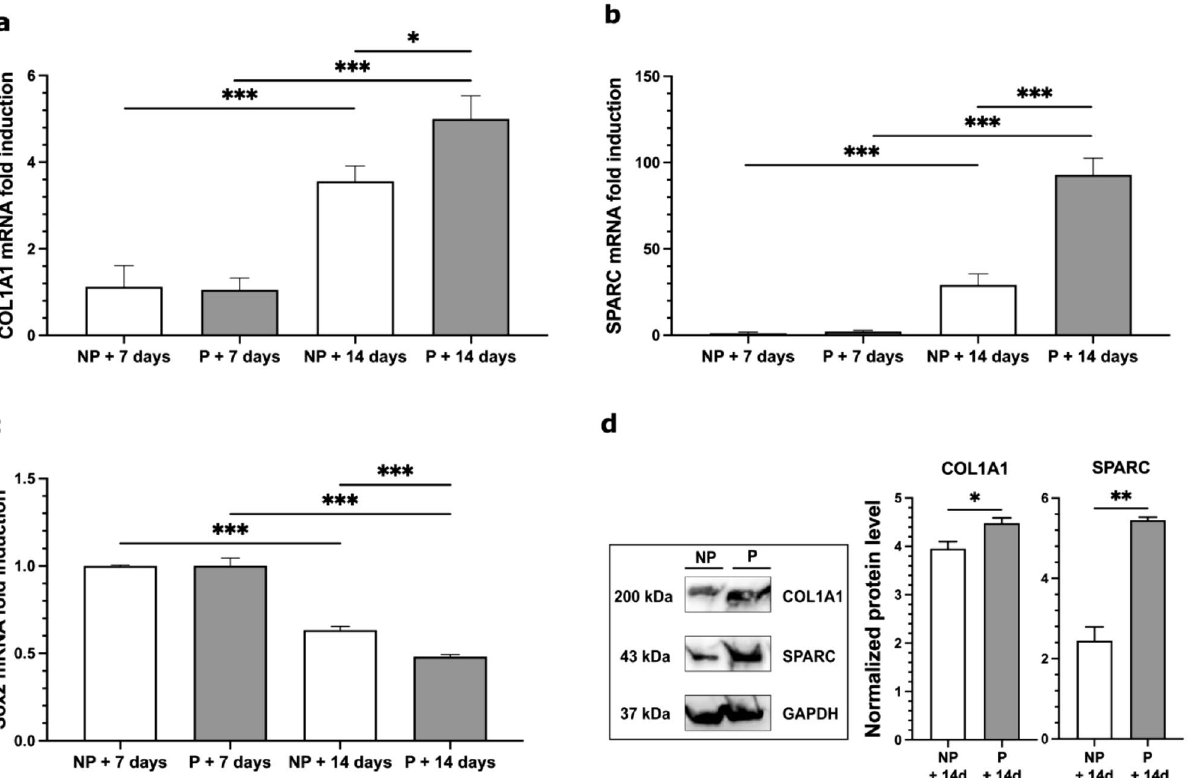
Figure 7. ( a – d ) mRNA relative expression analysis of COL1A1, SPARC and Sox2 genes and WB assay of COL1A1 and SPARC proteins. ( a – c ) mRNA relative expression analysis (mean + SEM) of COL1A1, SPARC and Sox2. ( a , b ) mRNA relative expression analysis of the osteogenic differentiation genes COL1A1 (i.e. pro-alpha1 chains of type I collagen) and SPARC (i.e. secreted protein acidic and rich in cysteine) in non-pored (NP) and pored (P) scaffolds, 7 and 14 days after seeding. Expression levels of both genes are increased in the d14 scaffolds in comparison to the d7 ones. ( c ) Conversely, a progressive decrease of Sox2 mRNA level in non-pored (NP) and pored (P) scaffolds was detected at d7 and d14, confirming the differentiation of MSCs during this time window. Real-time PCR analysis was performed in triplicate (n = 6 pig per experimental group; statistics by two-way ANOVA and Bonferroni post hoc). Data are expressed as mean ± SEM. *p < 0.05; ***p < 0.001. ( d ) Immunoblot analysis and bar graphs showing the levels of COL1A1 and SPARC in non-pored (NP) and pored (P) scaffolds seeded with hBM-MSCs for 14 days. Cropped images are from samples run on the same gel. Pored scaffolds showed a significant increase in both COL1A1 and SPARC protein levels compared to the non- pored samples ( n = 3; statistics using unpaired Student’s t test). GAPDH was used as loading control. Data are expressed as mean ± SEM. * p < 0.05; ** p < 0.01. Positive and negative controls, as well as molecular size markers and full-length blots are presented in Supplementary Figure